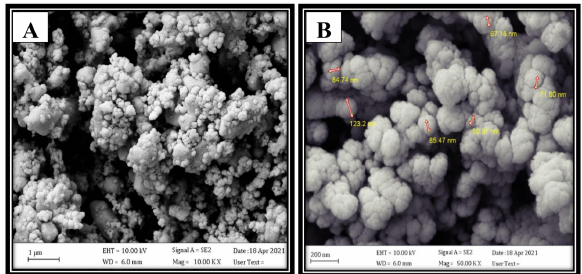
Figure 2: FESEM images of 𝛾 -Fe 2 O 3 -Ag 2 O nanocomposite at scale (A) 1 (cid:181) m and (B) 200